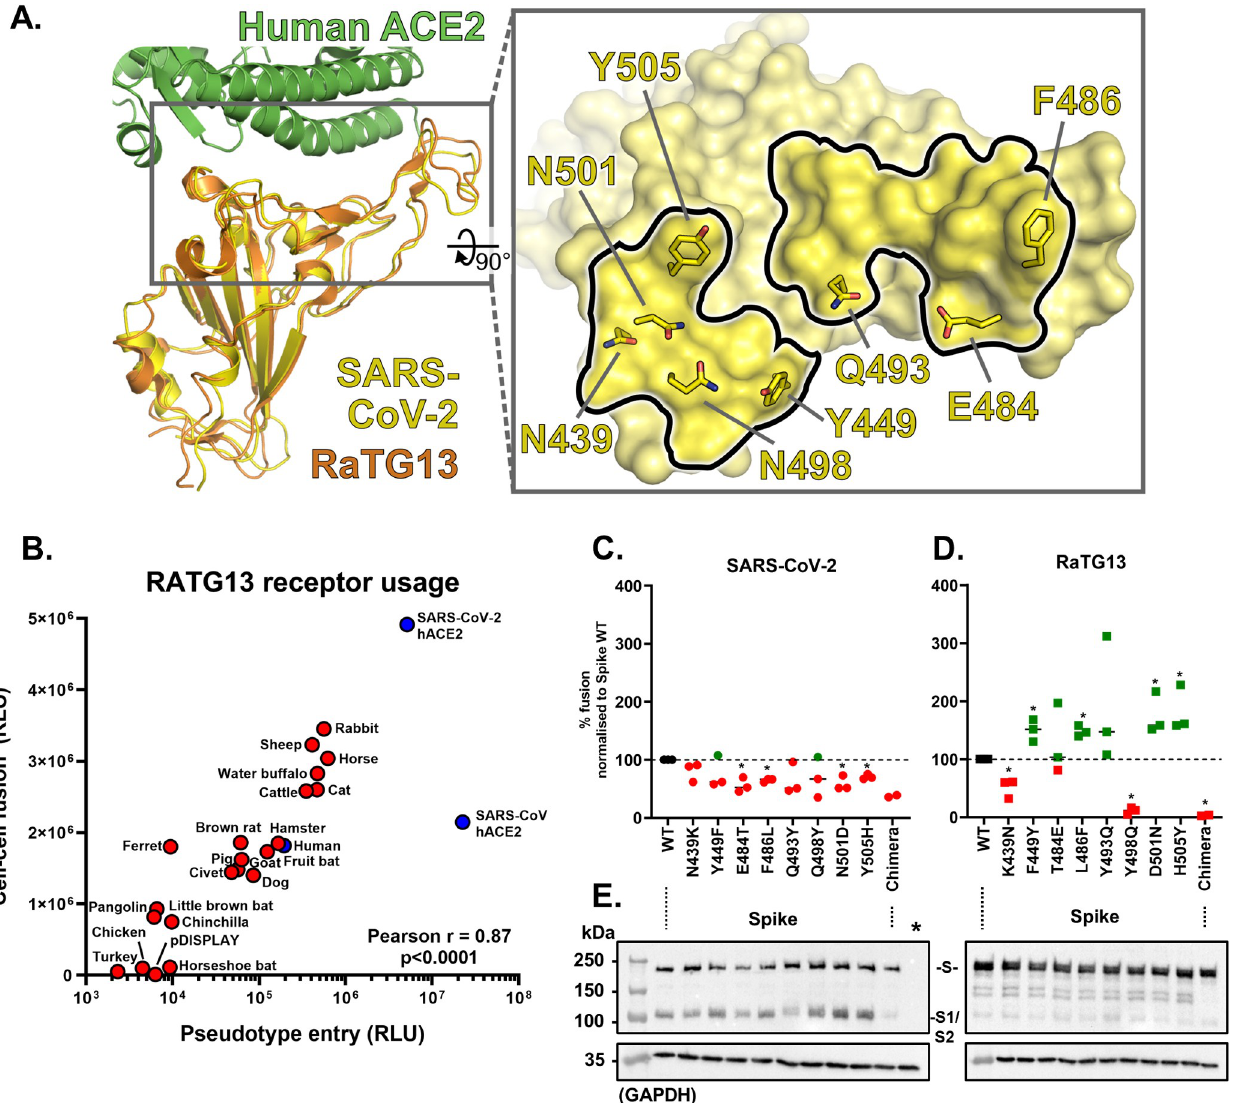
Fig 4. Amino acid substitutions within SARS-CoV-2 Spike RBD may have contributed to zoonotic emergence. (A) Comparison of the RBD structures of SARS-CoV-2 and RaTG13 Spike proteins [6,12] identified a high degree of structural similarity. Nevertheless, a number of amino acid changes between RaTG13 and SARS-CoV-2 were identified at residues interacting directly with ACE2 (according to [6]). SARS-CoV-2 N439, which does not interact directly with ACE2, was included because of its functional stabilisation role in the 498–505 loop, its previous identification within the SARS-CoV Spike RBD–ACE2 interface [19], and the N439K substitution present in RaTG13. (B) An XY scatter plot demonstrating the receptor usage profile of RaTG13 Spike in pseudotype (X) and cell–cell fusion assays (Y). Each point represents the mean signal seen from 3 experiments performed on separate days, with the human ACE2 highlighted in blue. Human ACE2 utilisation by SARS-CoV-2 and SARS-CoV Spike is also plotted for reference. In this graph, values are not normalised to human ACE2 since RaTG13 is, to our knowledge, not a human-tropic virus. (C and D) Specific amino acids within the RBDs of SARS-CoV-2 and RaTG13 Spike, which directly interact with ACE2 yet vary between these 2 sequences, were mutated to generate chimaeric SARS-CoV-2-RaTG13 Spike proteins. The cell–cell fusion activity of individual point mutants, as well as a full chimaera containing all 8 mutations (chimaera), was then examined using human ACE2 expressing target cells with activity normalised to the fusion seen with the wildtype (WT) viral glycoprotein of (C) SARS-CoV-2 or (D) RaTG13. The data points shown are the mean cell–cell fusion results seen in 3 completely independent experiments (green, increased relative activity; red, decreased relative activity). � p < 0.05 Student t test, compared with WT. (E) Expression of the same mutants was analysed by western blot targeting the flag tag fused to these Spike proteins (S, full-length Spike; S1/S2, cleaved variant). Results are representative of protein expression experiments performed in duplicate, with a GAPDH loading control also shown. The data underlying this figure may be found in S1 Data and S1 Raw Images. ACE2, angiotensin- converting enzyme 2; GAPDH, glyceraldehyde 3-phosphate dehydrogenase; RBD, receptor binding domain; RLU, relative light units; SARS-CoV, SARS Coronavirus; SARS-CoV-2, SARS Coronavirus 2; WT,